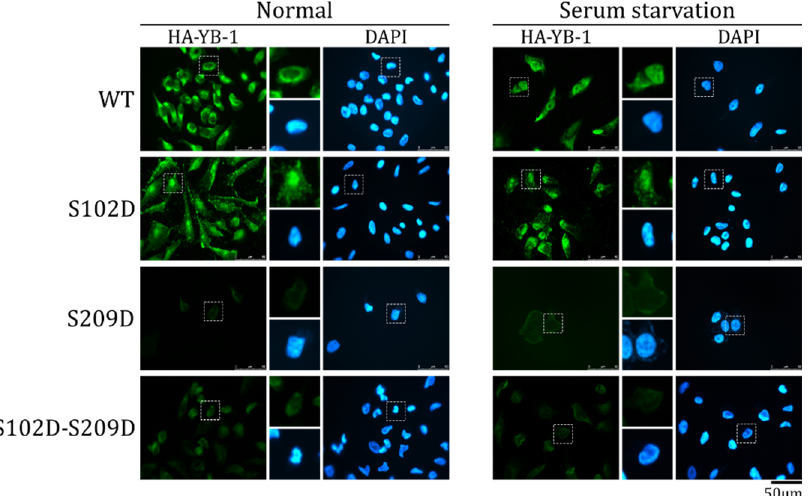
Figure 5. S209 phosphorylation inhibits S102-dependent YB-1 nuclear transport. Wild type (WT) HA-YB-1, HA-YB-1 S102D, HA-YB-1 S209D, and HA-YB-1 S102D-S209D recombinant proteins were used in an in vitro transport system. HeLa cells were cultivated in normal ( left panel) and serum starvation ( right panel) conditions before permeabilization and to obtain cytosol. Localization of HA-YB-1 was analyzed by IF microscopy using anti-HA antibodies. Quantification of at least three independent replicates of the in vitro transport assay are shown in Figure S3.